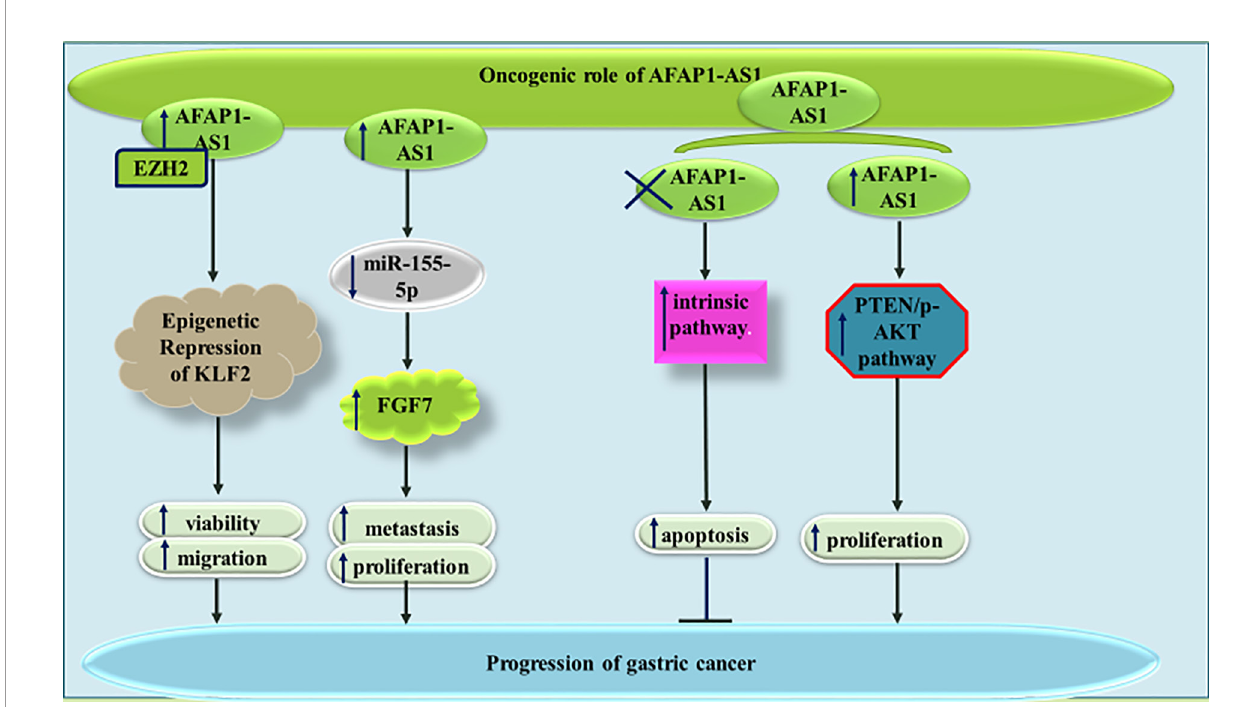
FIGURE 5 | The oncogenic role of AFAP1-AS1 in gastric cancer is exerted through repression of KLF2, sponging miR-155-5p and enhancing activity of PTEN/p- AKT